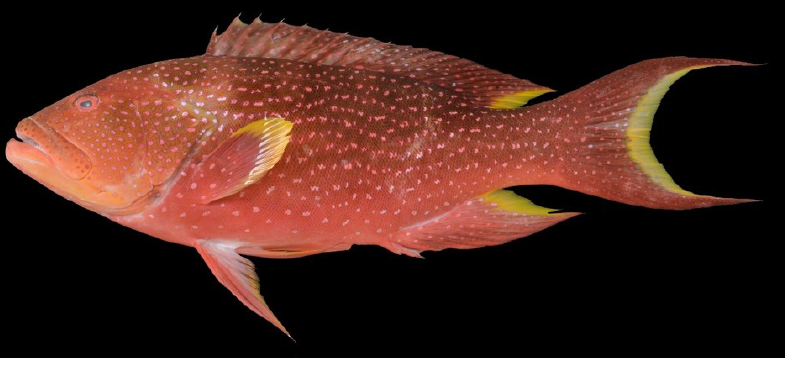
measured at NIHS. The frozen flesh samples were stored at − 30 ◦ C until use. The